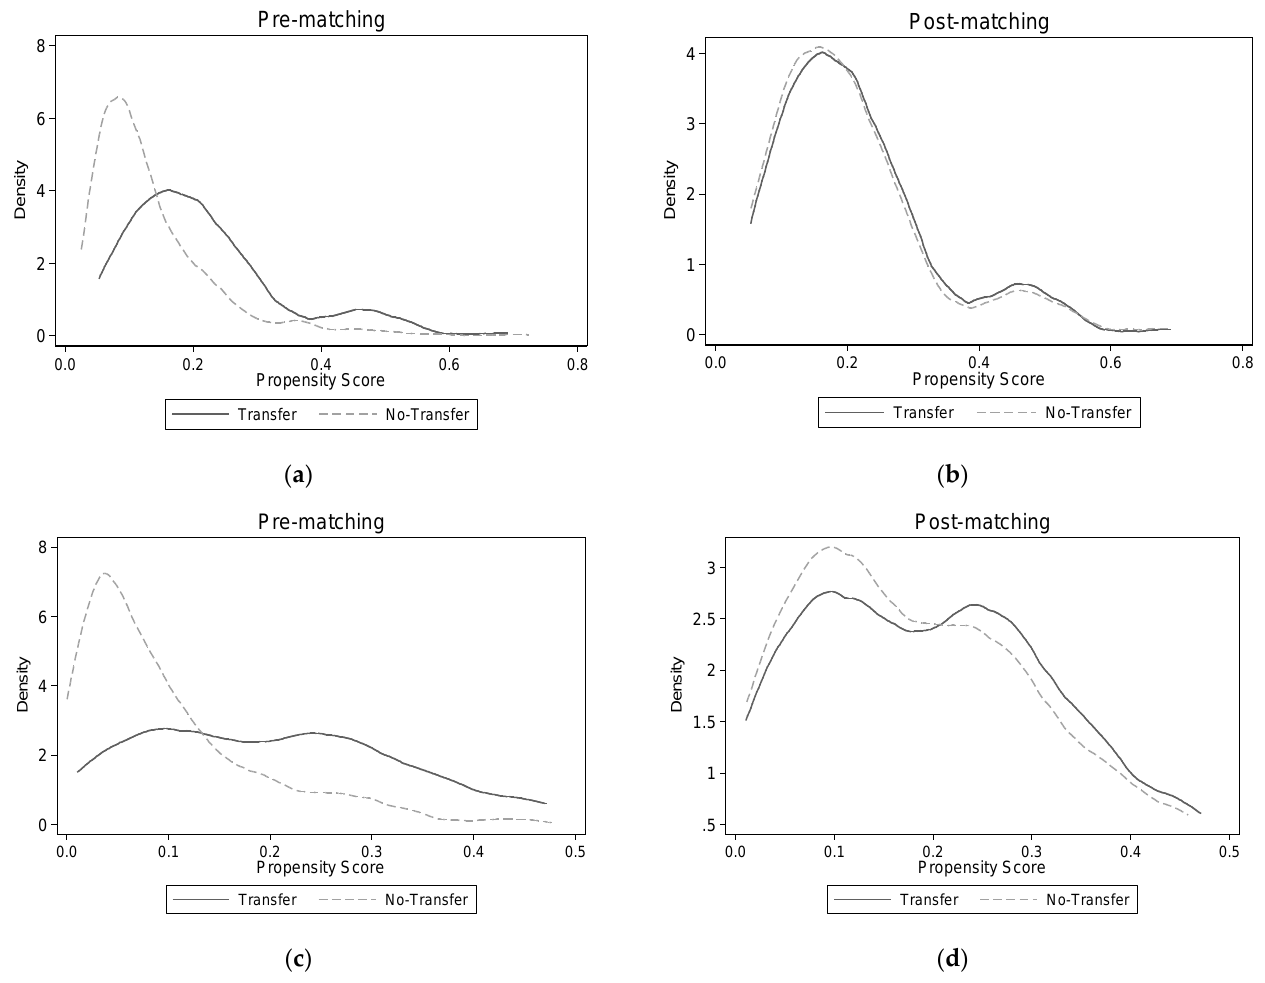
Figure 1. Kernel density distribution of propensity scores before ( a , c ) and after ( b , d ) matching.